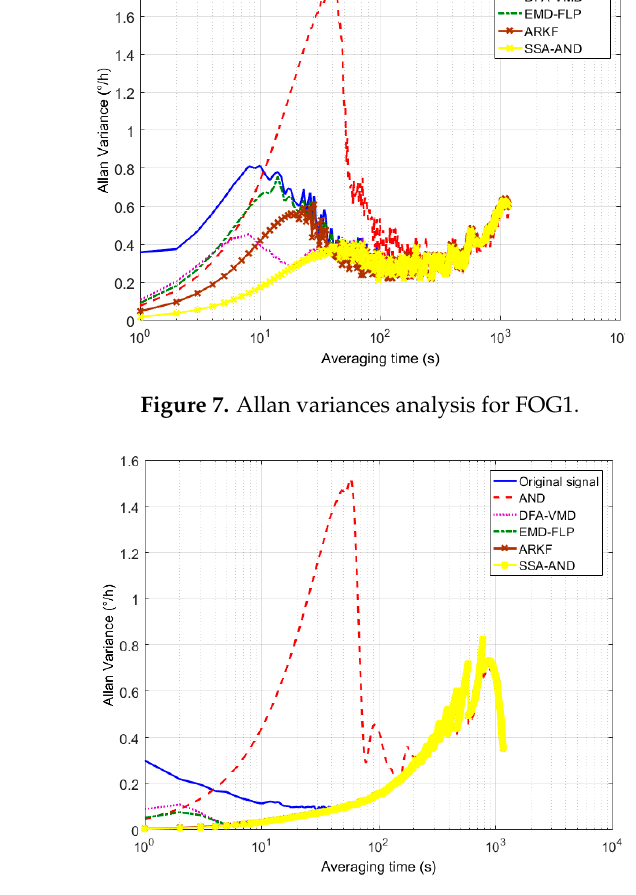
Figure 8. Allan variances analysis for FOG2. Table 3. Allan variance analysis results after de-noising of FOG1 and FOG2.